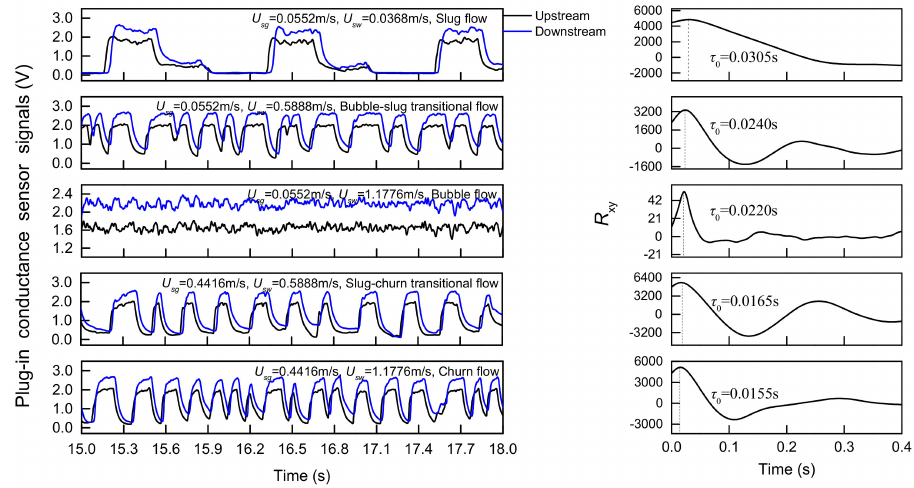
Figure 9. The responses of plug-in cross-correlation conductance sensor and correlation function